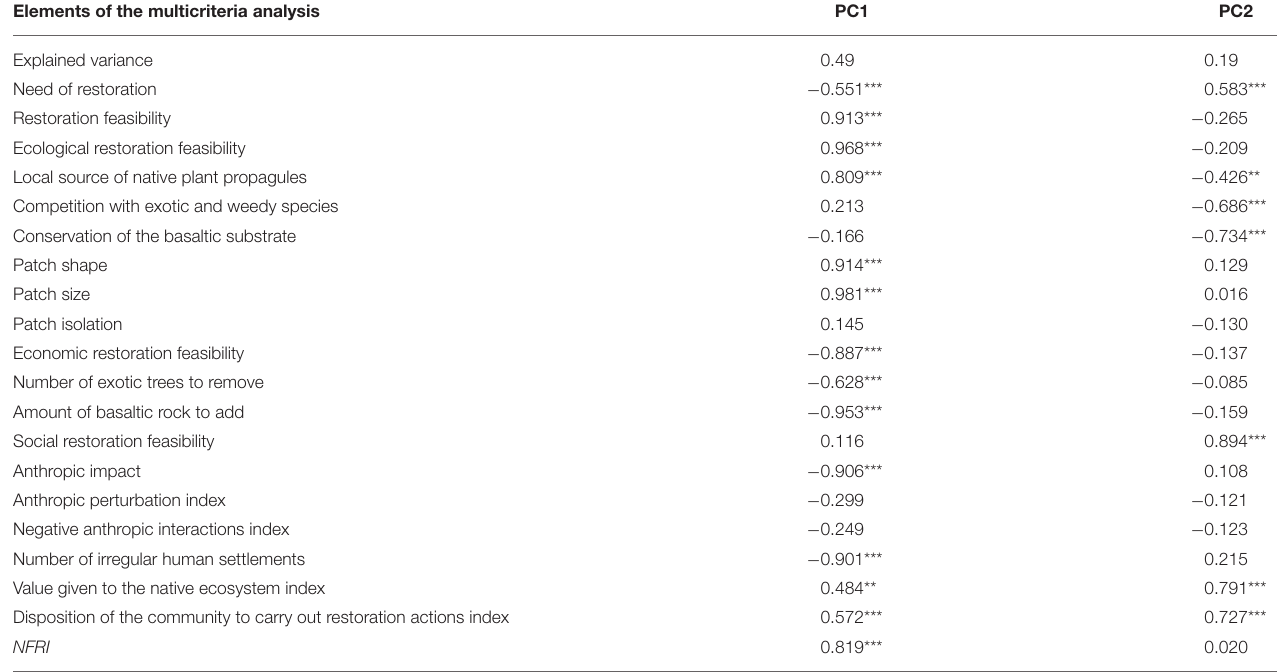
TABLE 3 | Proportion of variance explained by the first two principal components (PC) and Pearson correlation of PC’s with each element of the multicriteria analysis. Elements of the multicriteria analysis Explained